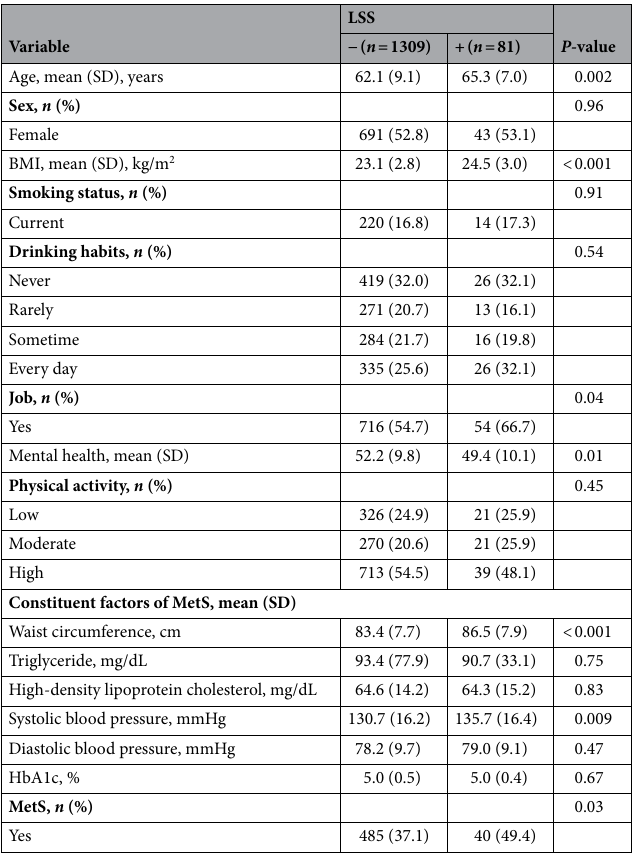
Table 1. Characteristics of participants according to lumber spinal stenosis ( n = 1390). MetS metabolic syndrome, BMI body mass index, LSS lumbar spinal stenosis, HbA1c hemoglobin A1c.